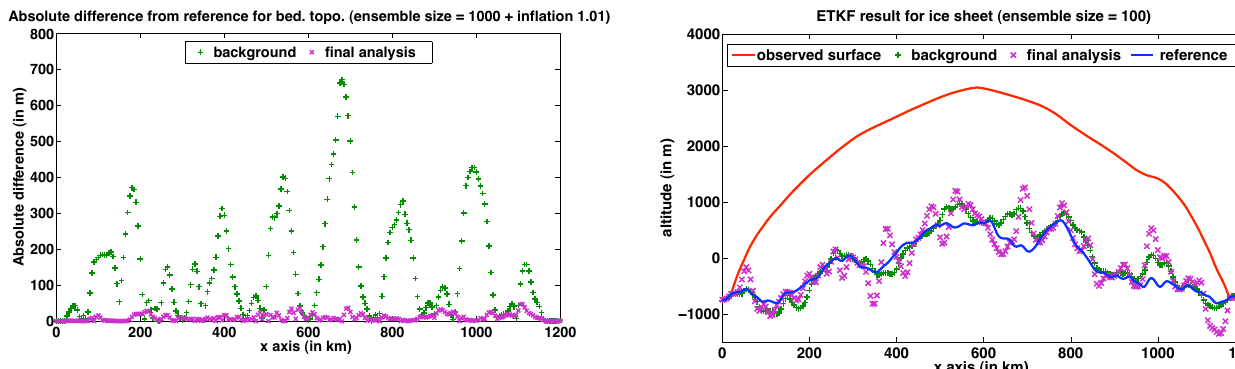
Fig. 15. Bedrock topography after 20 years, with the 100-member ETKF (no inflation, no localisation). The analysis (final mean en- semble in purple x) is compared to the background (green crosses) and the reference (blue). RMS error increases from 207.5m for the background state to 302.4m for the final analysis step and the max- imal absolute difference from 671.6 to 1093.7m.